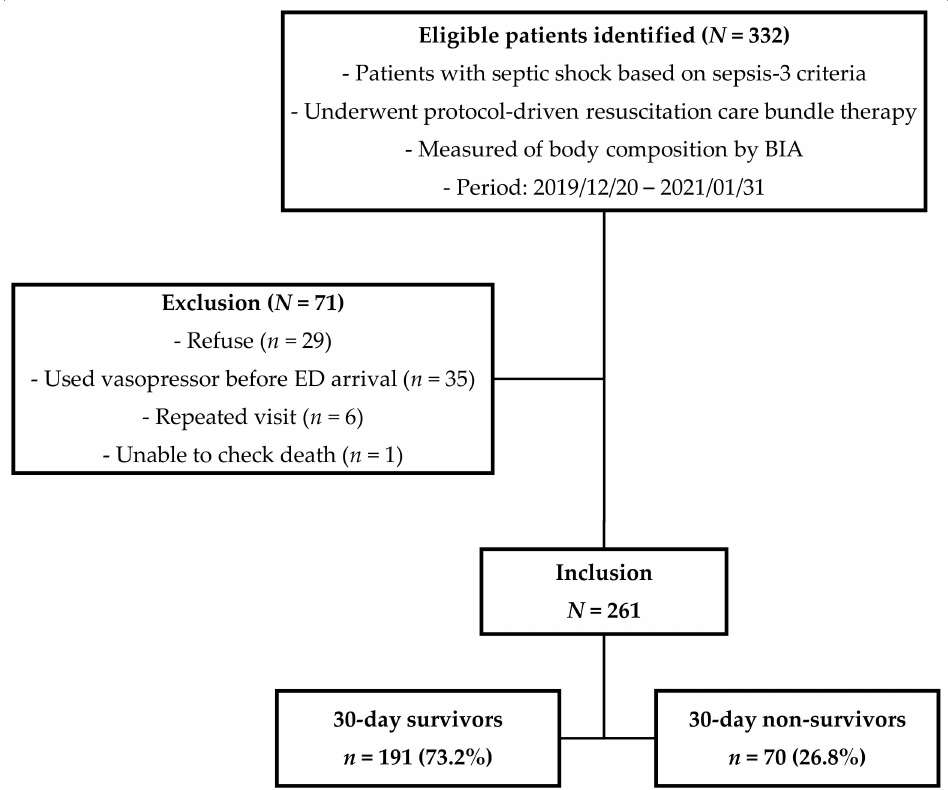
Figure 1. Patient flow diagram. BIA, Bio-electrical impedance analysis; ED, emergency department. Patients with septic shock based on sepsis-3 criteria who underwent protocol-driven resuscitation care bundle therapy and measurements of body composition by Bio-electrical impedance analysis. From December 2019 to January 2021, 261 patients were enrolled and the overall 30-day mortality rate was 26.8%. Table 1. Comparison of the clinical characteristics between the 30-day non-survivor group and the 30-day survivor group. Total 30-Day Survivors ( n = 261) ( n =